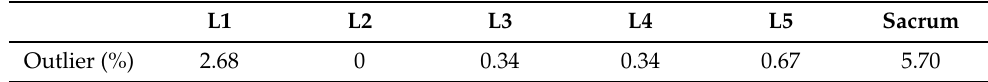
Table 9. Average outlier ratio for each vertebra.